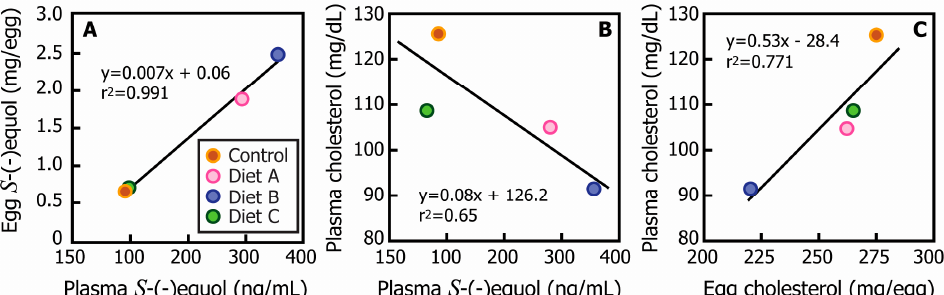
Figure 3. Plots showing ( A ) a positive correlation between the average egg plasma S -(-)equol content ( μ g/egg, n = 10) and average plasma S -(-)equol concentration (ng/mL, n = 10), ( B ) an inverse relationship between plasma cholesterol and plasma S -(-)equol concentration (ng/mL, n = 10), and ( C ) a positive correlation between plasma cholesterol concentration and egg-yolk cholesterol content of hens fed commercial corn/soymeal diet (Control), and the same diet with added isoflavone glycosides from soy germ (diet A), isoflavone aglycons from a soy germ pasta (diet B) or with